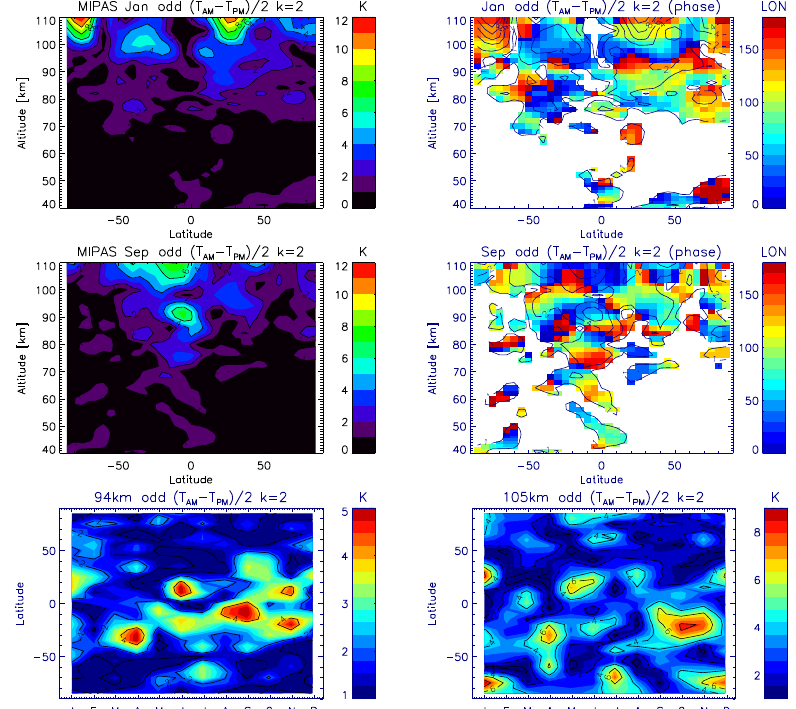
Figure 8. Latitude–altitude amplitude (left) and phase (right) fields for January (first row) and September (second row) and latitude–time horizontal slices of amplitudes (third row) at 94km (left) and 105km (right) of MIPAS average (2007–2012) | n odd − s | = 2 mode. Effects from DW3, DE1 and TW1 tidal modes are